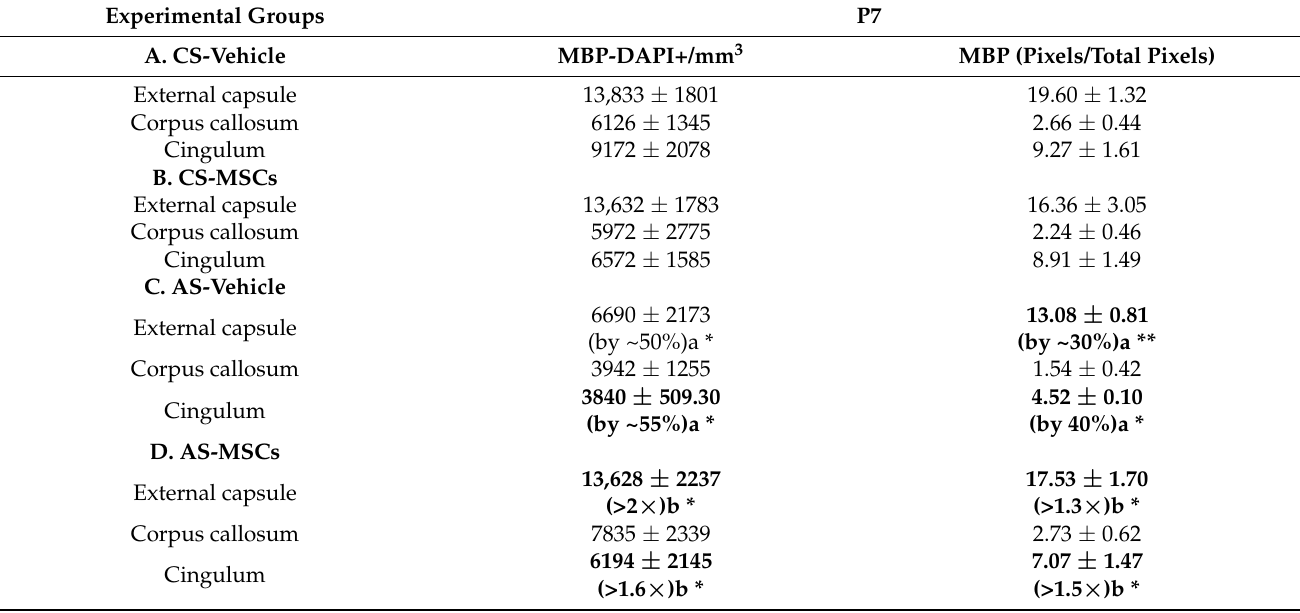
(cf. Table 6C versus Table 6A), but no differences were observed in corpus callosum among any of the groups (vehicle- or MSCs-treated, CS, or AS animals). Table 6. Effect of perinatal asphyxia (PA) on oligodendrocytes (MBP-DAPI/mm 3 ) and myelination (MBP positive pixels/total pixels) in telencephalon from control (CS) and asphyxia-exposed (AS) rats at P7: Effect of neonatal MSCs treatment. Coro- nal sections of telencephalon were treated for immunohistochemistry against myelin basic protein (MBP), counterstained with DAPI. Microphotographs (two-five samples per brain region) were taken from external capsule; corpus callosum, and cingu- lum, in the field of a confocal-inverted Olympus-fv10i microscope at 60 × . The mean number of glial cells per mm 3 and per- centage of MBP immunopositive pixels over the total pixel number was estimated using ImageJ software. Data are shown as means ± S.E.M from at least n = 5 independent experiments. Unbalanced two-way ANOVA indicated a significant effect of PA on MBP-DAPI/mm 3 and myelination (MBP pixels/total pixels), diminishing in external capsule and cingulum of AS vehi- cle versus CS vehicle (a), but increasing significantly in external capsule (F(2, 15) = 4.412, p < 0.03, DAPI/mm 3 ; F(2, 16) = 2.813, p < 0.03, myelination, respectively); and cingulum (F(2, 13) = 2.632, p < 0.04, DAPI/mm 3 ; F(2, 13) = 3.177, p < 0.03, myelination, respectively) of MSCs-compared to vehicle-treated AS rat neonates (b). No effect, however, was observed in corpus callosum (F(2, 15) = 0.738, p = 0.450, DAPI/mm 3 ; F(2, 14) = 1.484, p = 0.151, myelination, respectively). Benjamini–Hochberg was used as a post hoc